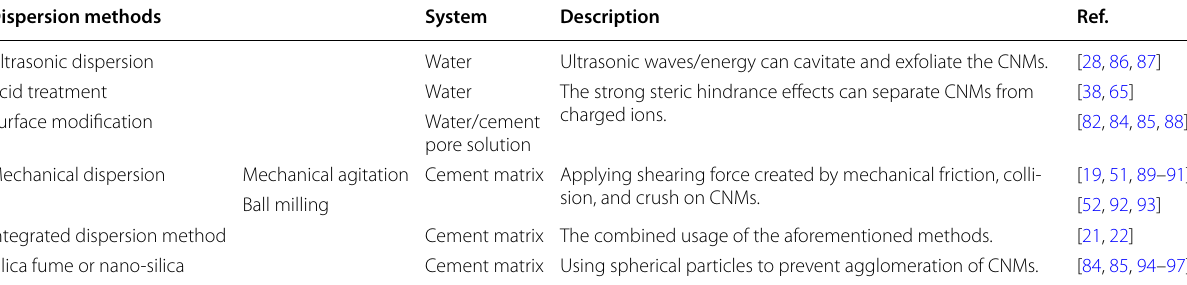
Table 2 Dispersion methods of CNMs in water and cement